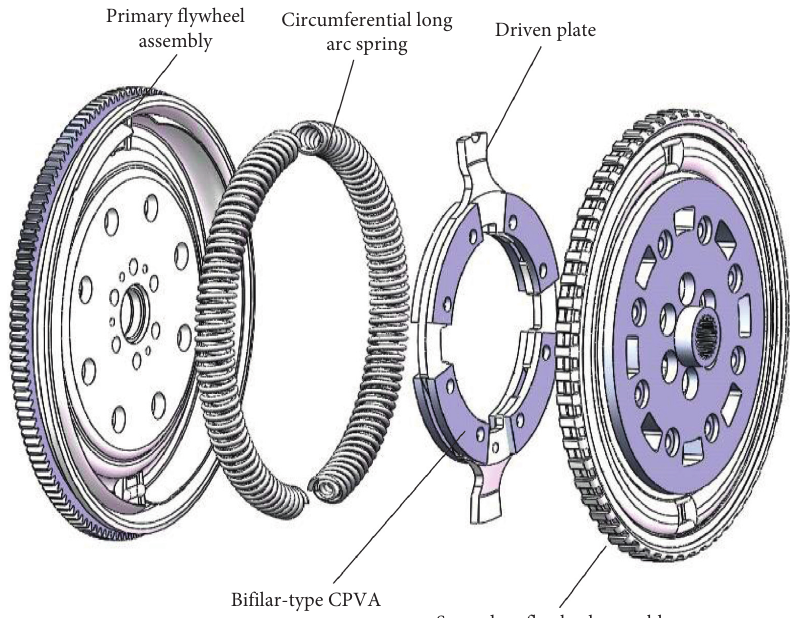
Figure 1: Schematic diagram of the DMF with bifilar CPVA.